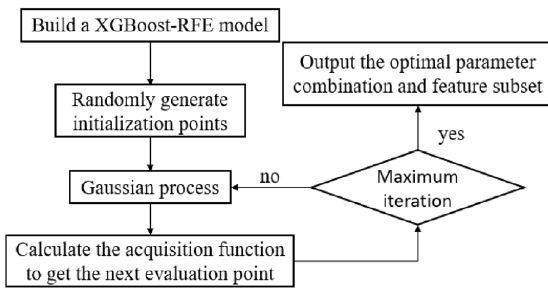
Figure 2. BO-XGBoost-RFE.